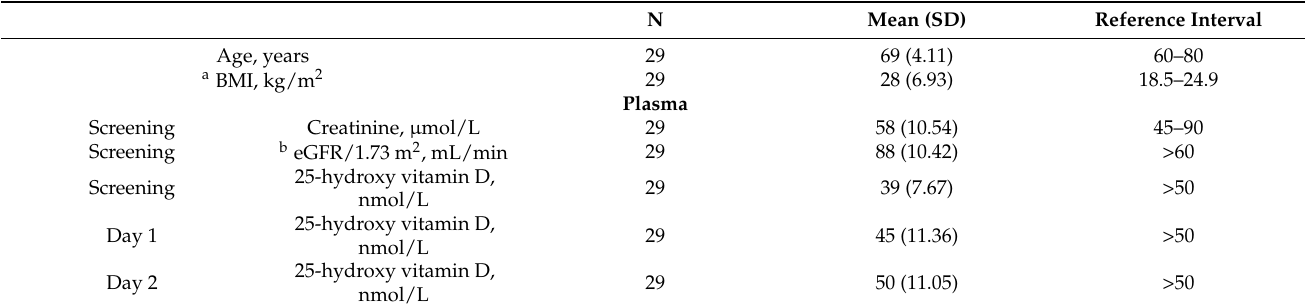
Table 1. Characteristics of included